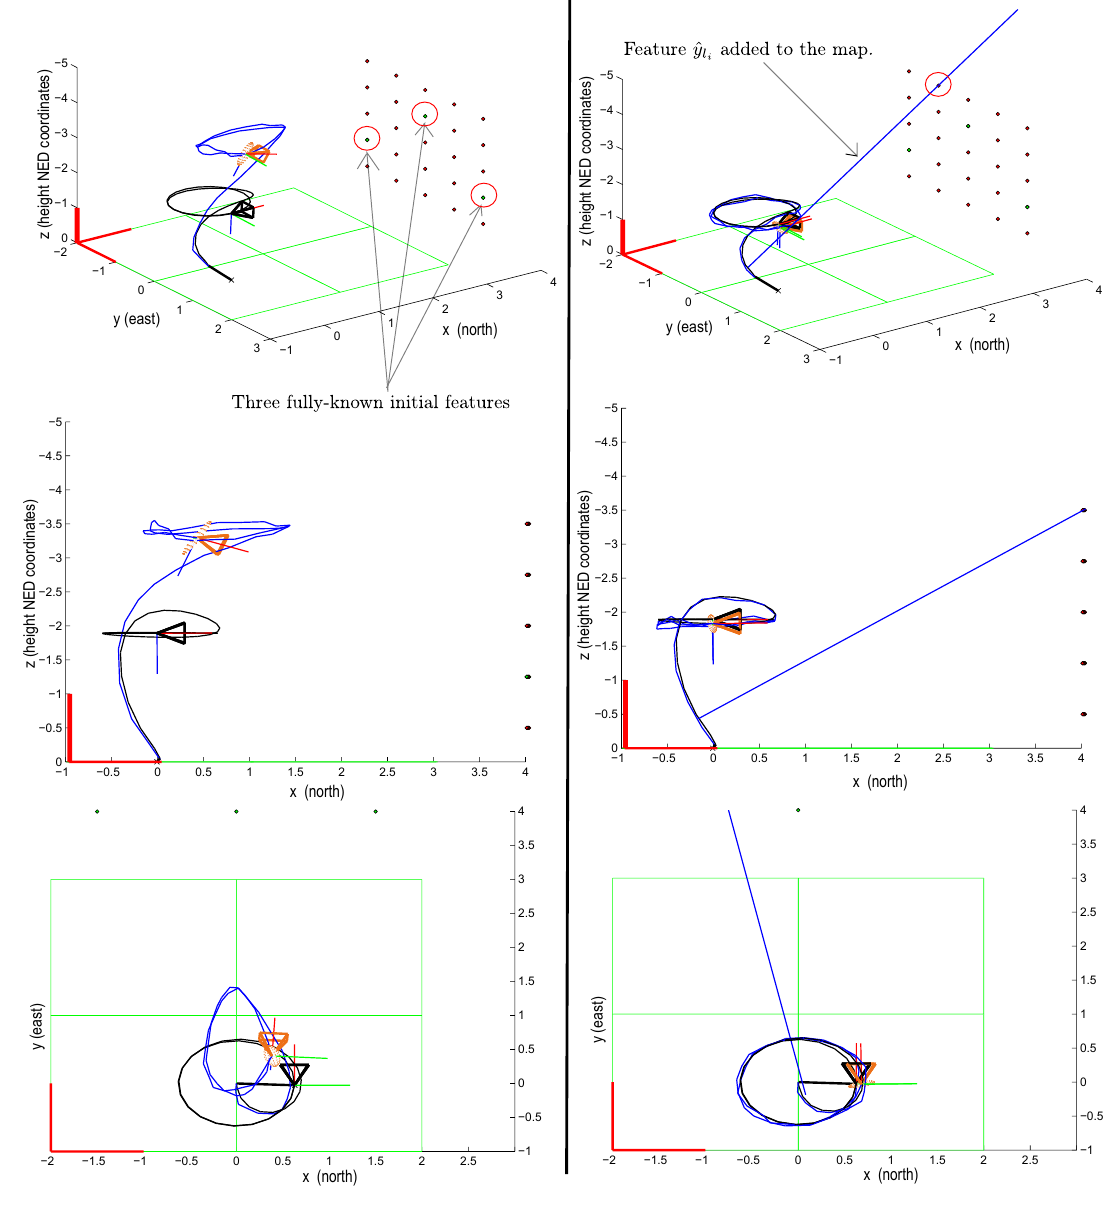
Figure 5. These simulations show the positive effect of the inclusion into the map of features with unknown depth, y . In the first simulation (left plots), the map has been initialized with l i three landmarks whose location is perfectly known. In the second simulation (right plots), a single feature, y , is added to the map. It can be noted that the estimated trajectory (in blue) l i is considerably better, when the feature, y , is l i